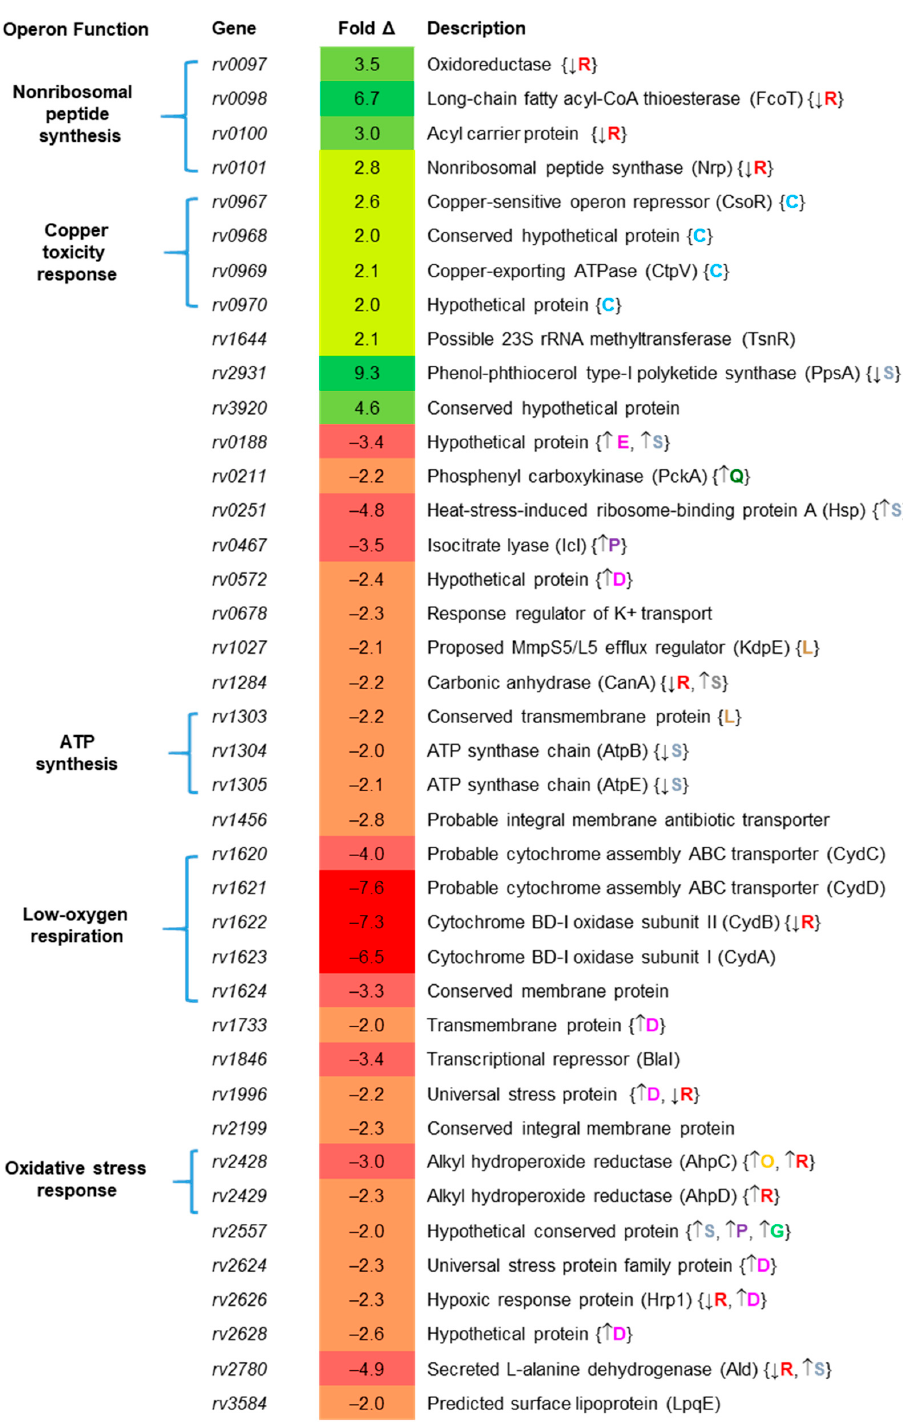
Figure 4. Genes differentially expressed >2-fold in Erdman and Δ sigC cultured in SMT. Genes predicted to be in the same operon are grouped by proposed operon function. Some of the identified conditions/regulators and direction (arrows) of specific gene are indicated (within {braces}). Code: C = copper/CsoR (light blue font) [31], D = DosR/hypoxia (pink font) [33], E = enduring hypoxic response (dark blue font) [34], G = in granulomas (green font) [35], L = RelMtb stringent response (brown font) [36], O = oxidative stress (orange font) [37], P = anaerobic persistence (purple font) [38], Q = acid and hypoxia (dark green font) [39], R = SenX3/RegX3 (red font) [29], S = in vitro starvation (gray font) [40]. Fold-changes for the genes shown are the average of 4 independent experiments. If fold-change was less than one, the (negative) reciprocal is listed. Genes with >2-fold significant differential expression after SAM analysis are shown.